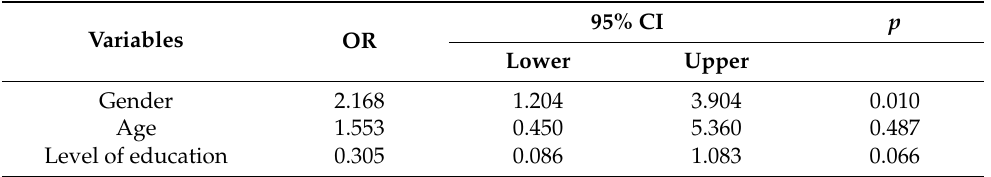
Table 2. The multivariate result logistic regression showing the odds ratio between the socio- demographics and ARH